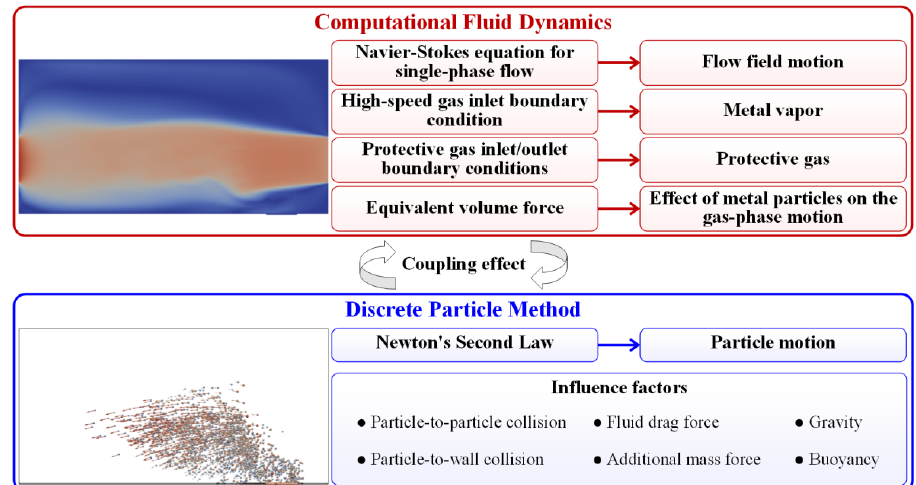
Figure 1. Simulation flow of the adopted Eulerian–Lagrangian method.